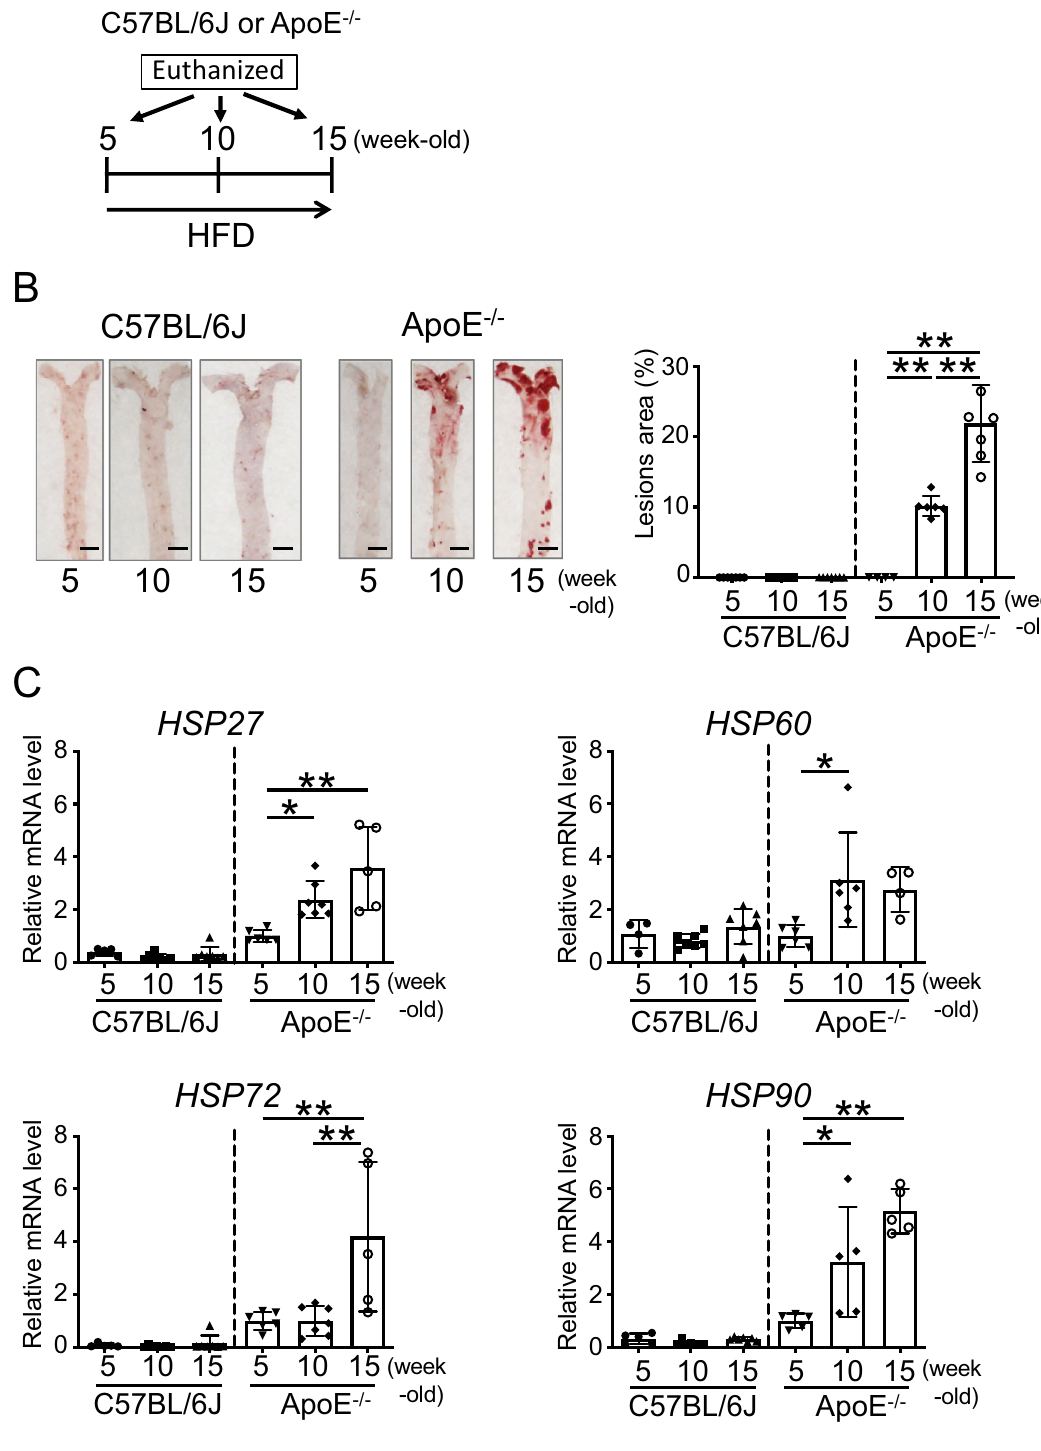
Figure 1. Progression of atherosclerosis and expression of heat shock proteins (HSPs). ( A ) Representation of the experimental timeline. ( B ) Oil Red O staining of the aorta of C57BL/6 J and ApoE −/− mice fed a high-fat diet (HFD) for 0, 5, or 10 weeks (5, 10, or 15 weeks old, respectively) (left). Bar graph showing the quantification of atherosclerotic areas (right). ( C ) HSP27 , 60 , 72 , and 90 mRNA expression levels in the aorta of C57BL/6 J and ApoE −/− mice fed an HFD for 0, 5, or 10 weeks (5, 10, or 15 weeks old, respectively). Each bar represents the mean ± standard deviation (SD). Significant differences are marked on the chart (*p < 0.05; **p < 0.01). n = 5–7 mice per group. Scale bars = 2